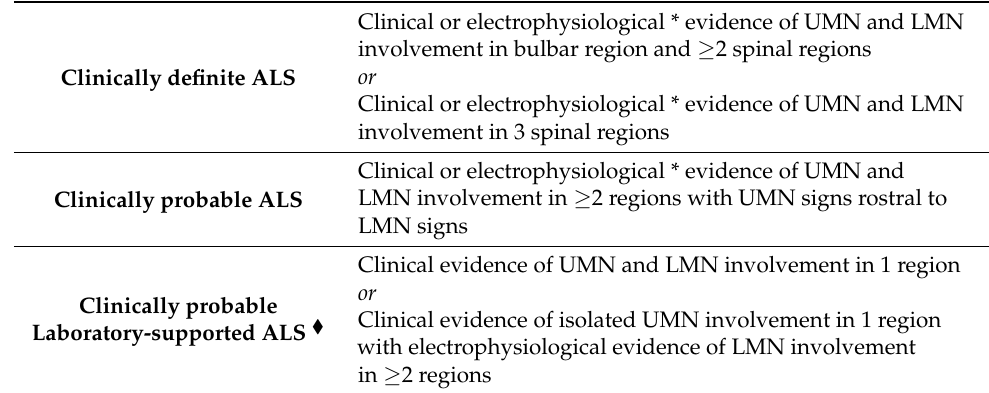
Table 1. The revised El Escorial criteria (2000) and the Awaji criteria